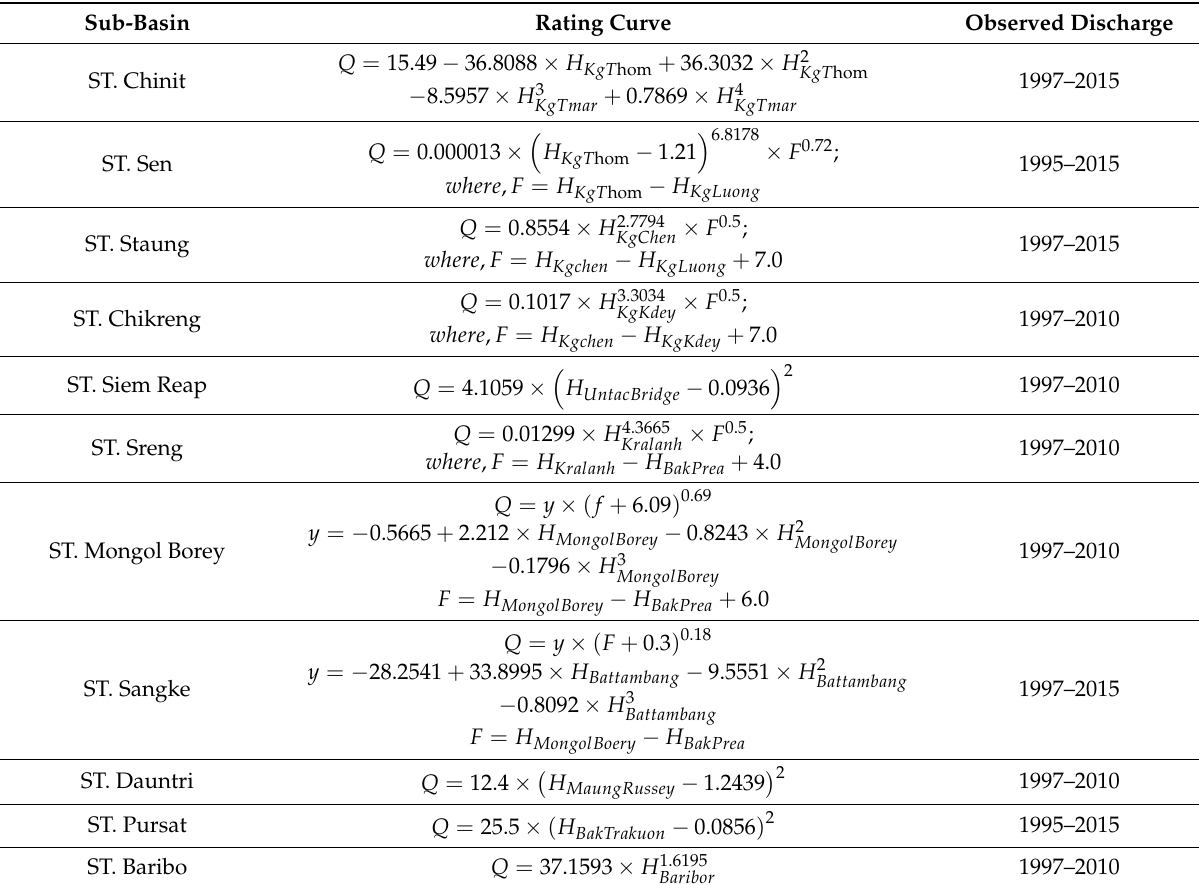
Table A1. Rating curve developed to estimate river flows [26] for the monitored water levels at the outlets of the 11 Tonle Sap